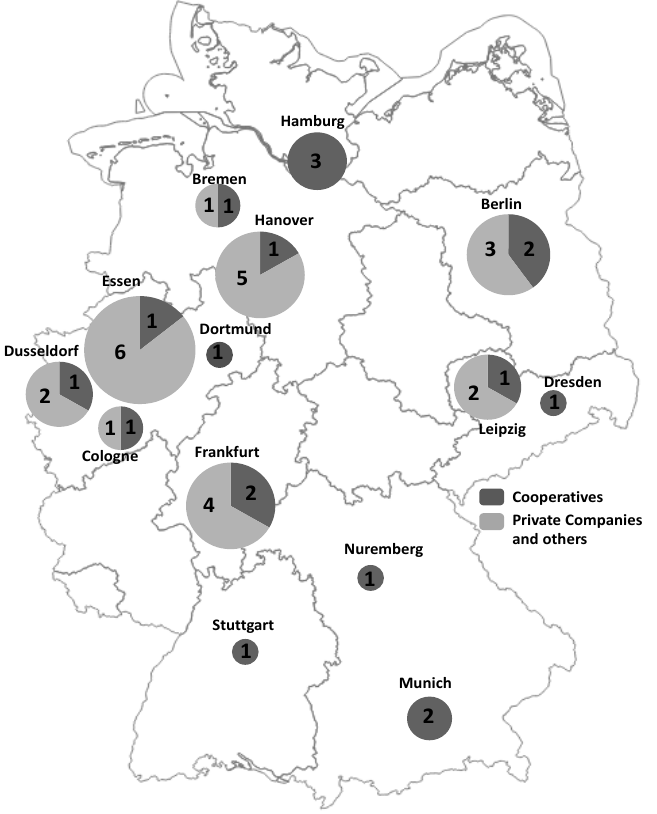
Figure 1. Number of RDSs in German